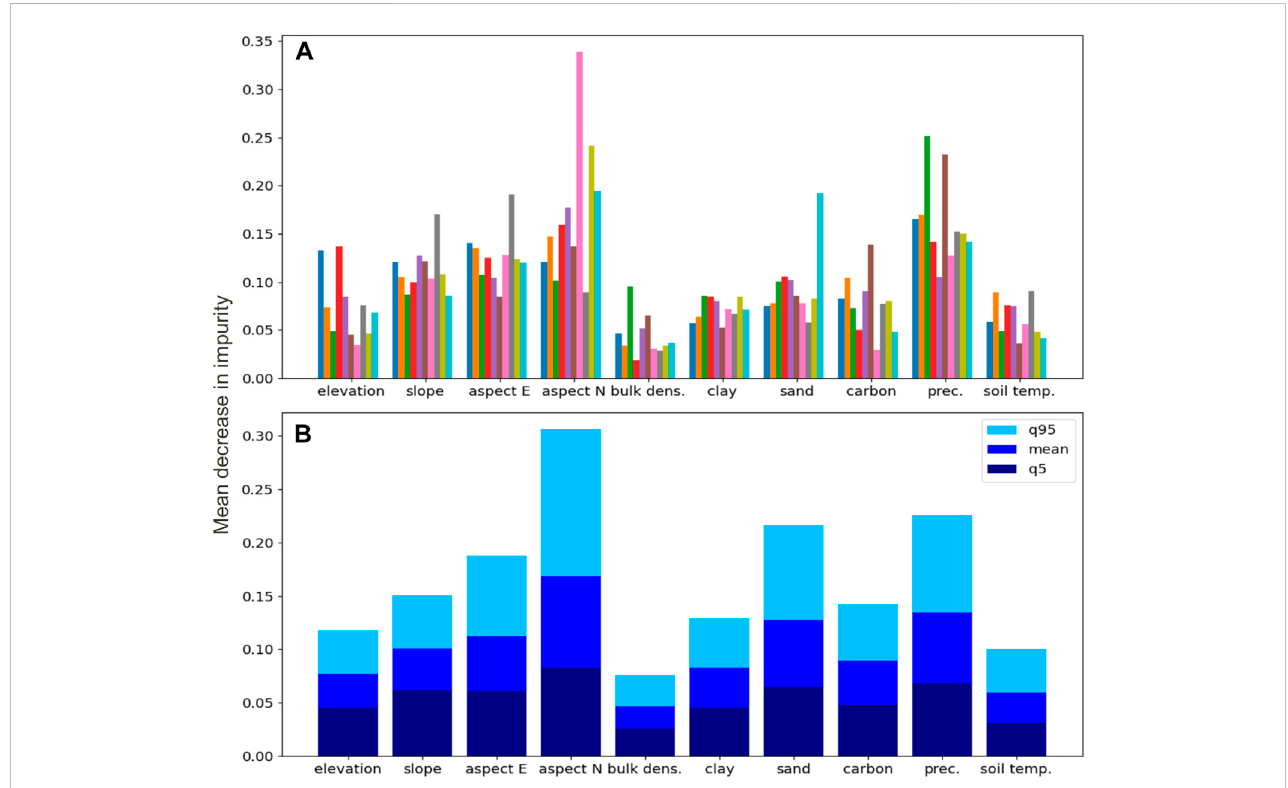
FIGURE 8 Relative feature importance within the training dataset for the fi rst instances of the Monte Carlo approach (A) and main statistic values (mean, fi fth and 95th percentiles) after 1,000 iterations (B) . The large dispersion shows how the feature importance varies with the noise in the input data.